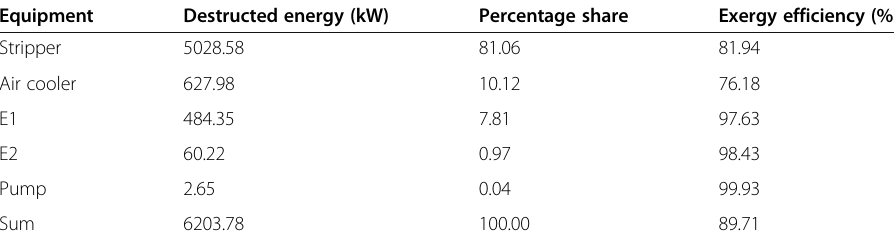
Table 9 Exergy destruction and exergy efficiency results